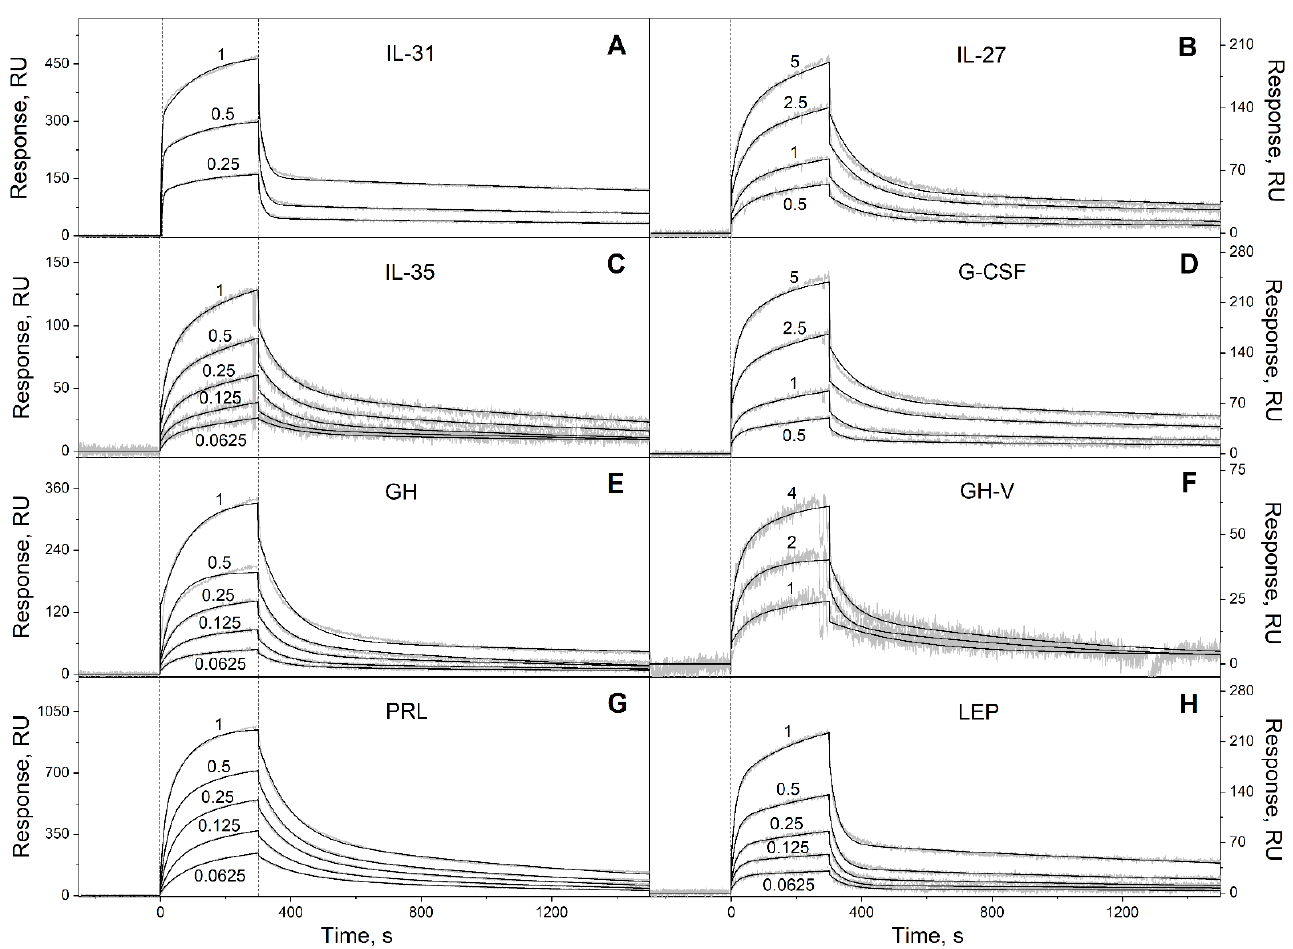
Figure 2. Kinetics of the interaction of Ca 2+ -loaded S100P with specific long-chain four-helical cytokines shown in Table 2 at 25 °C, monitored by SPR spectroscopy using S100P as an analyte and the cytokines as a ligand immobilized on the sensor chip surface by amine coupling. ( A ): IL-31; ( B ): IL-27; ( C ): IL-35; ( D ): G-CSF; ( E ): GH; ( F ): GH-V; ( G ): PRL; ( H ): LEP. Buffer conditions: 10 mM HEPES, 150 mM NaCl, 1 mM CaCl 2 , 0.05% TWEEN 20, pH 7.4. The vertical dotted lines mark the association phase, followed by the dissociation phase. Molar analyte concentrations (µM) are indicated for the sensograms. The gray curves are experimental, while the black curves are theoretical, calculated according to the heterogeneous ligand model (1) (see Table 3).